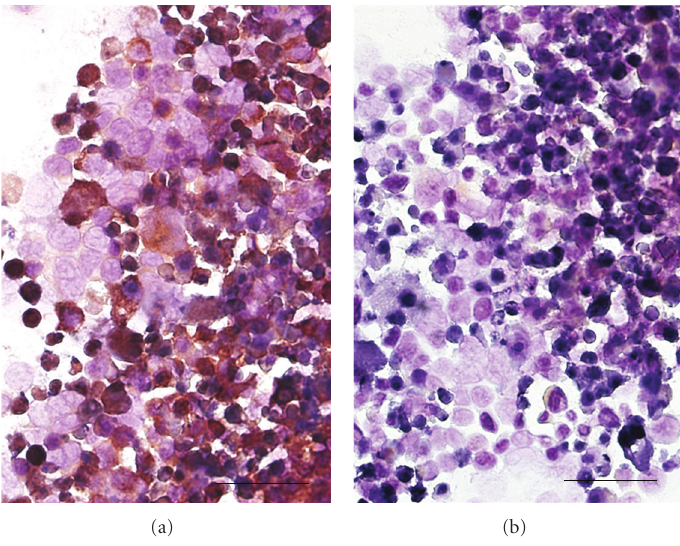
Figure 1: Germ cell proteins are often expressed in melanoma. Shown is a melanoma line DM2N stained with (a) and without (b) a primary antibody to REC8 (ProteinTech, Chicago, IL), a protein involved in chromosomal cohesion and crossover events in meiosis. The red staining (a) reveals that REC8 is abundantly expressed and is heterogeneous both in the level of expression and localization. It is possible that REC8 and other expressed germ cell proteins contribute to the chromosomal instability seen in melanoma and others tumors (size bar 50 μ